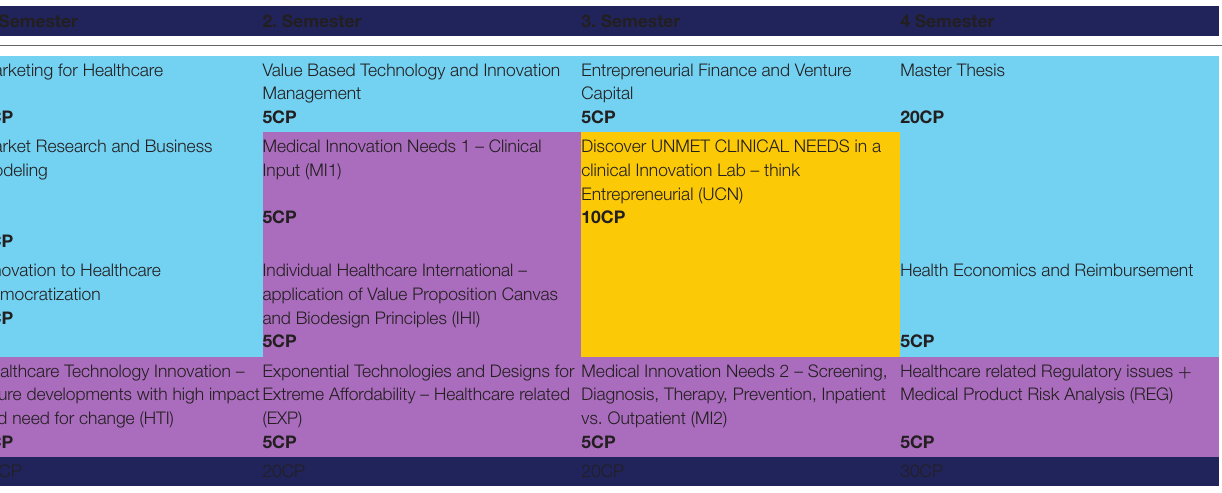
TABLE 1 | Proposed study plan suggestion for a novel master curriculum in Health Tech Innovation